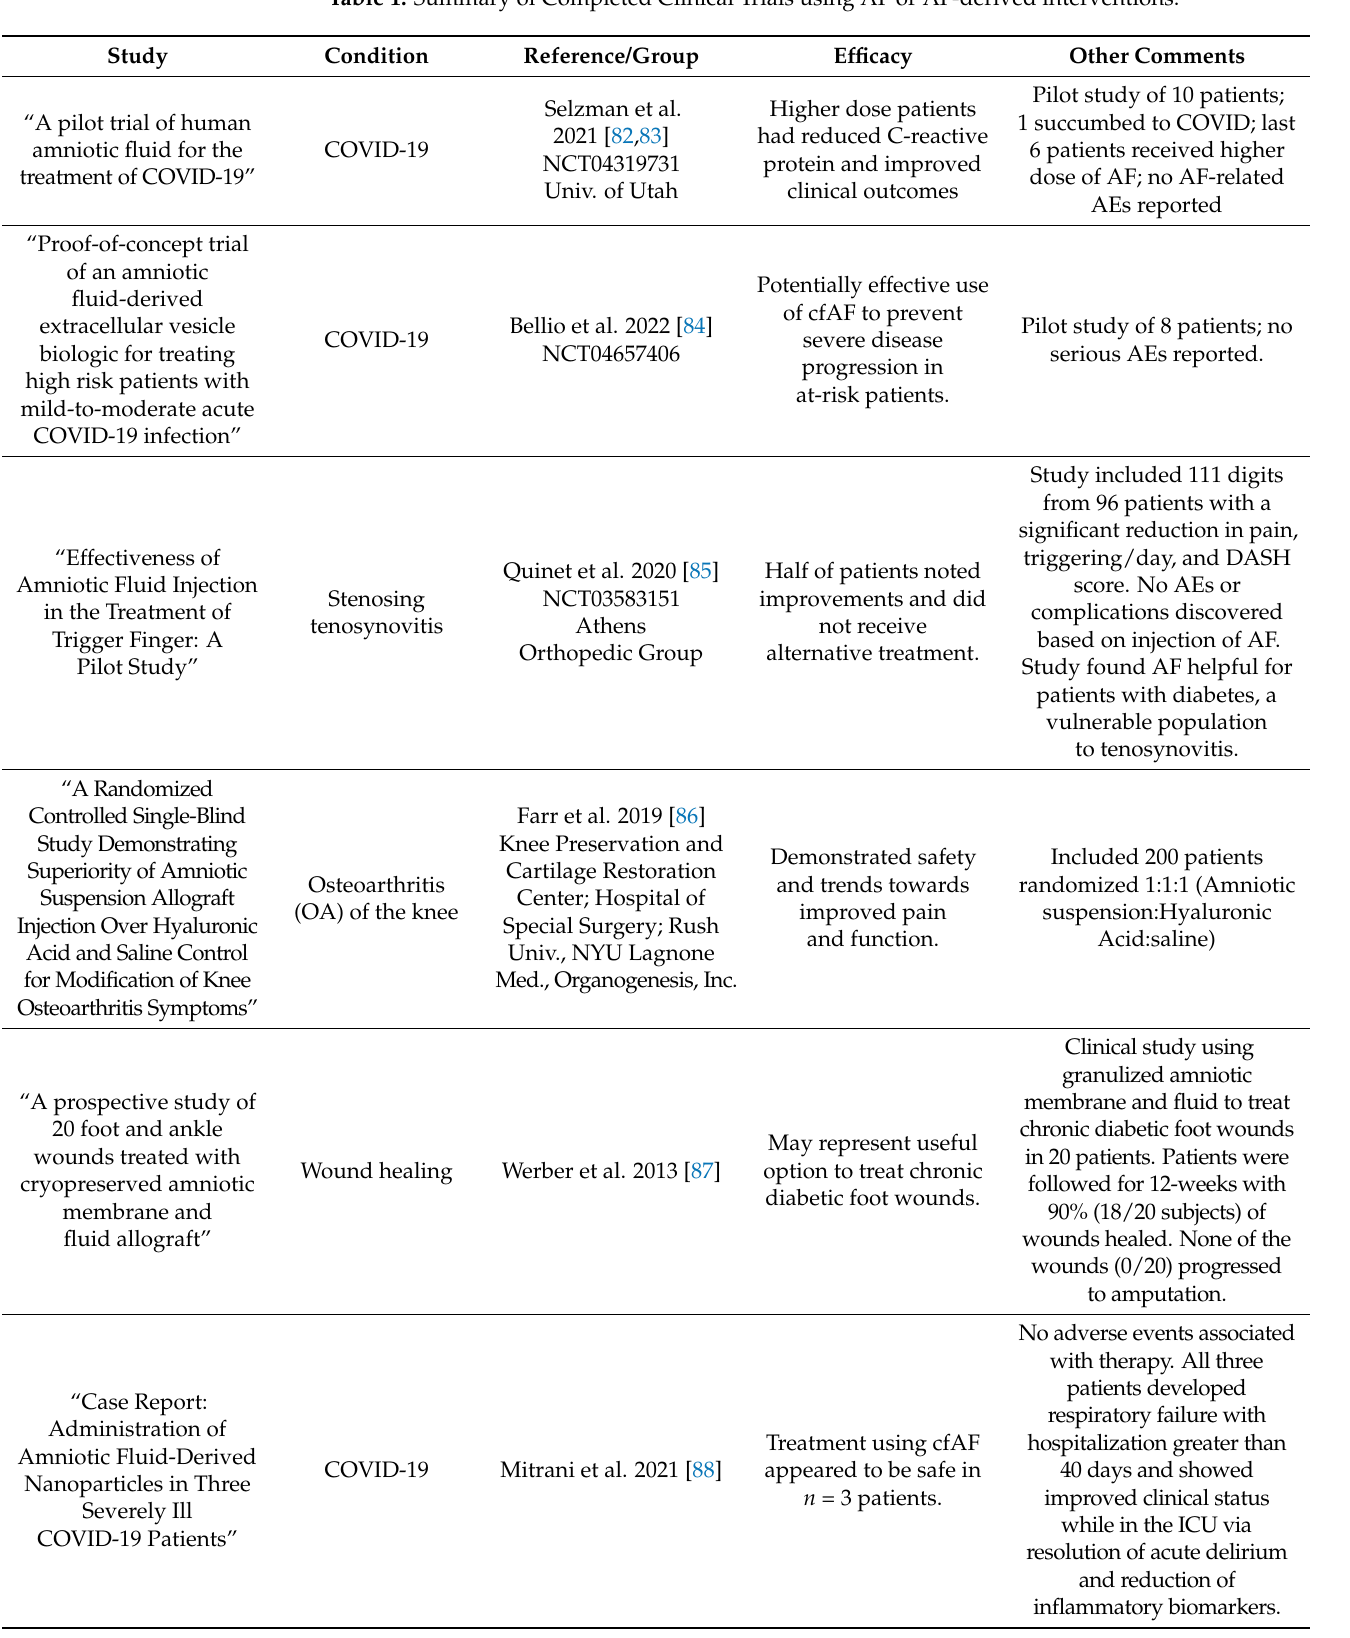
Table 1. Summary of Completed Clinical Trials using AF or AF-derived